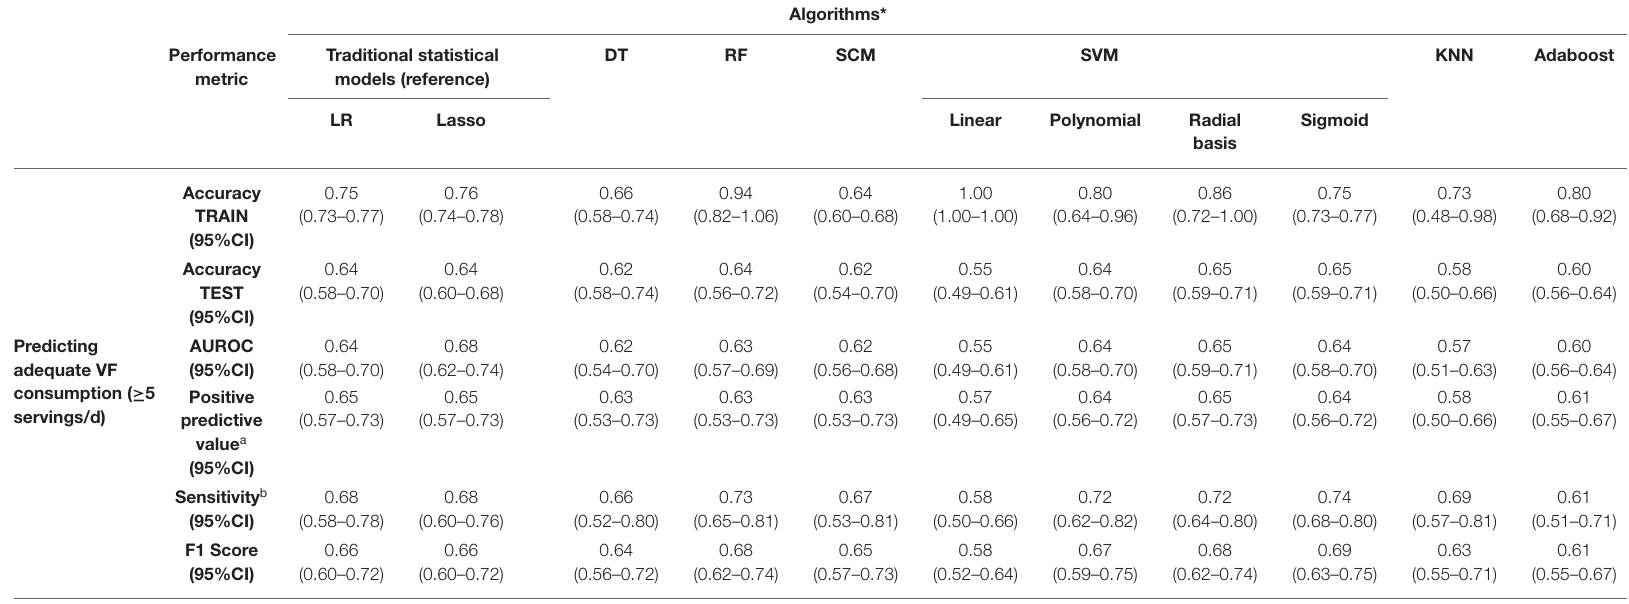
TABLE 4 | Performance metrics of two traditional statistical models and nine machine learning algorithms to predict adequate vegetable and fruit (VF) consumption based on dietary intake data obtained from web-based 24-hr recalls (R24W) among1147 French-speaking adults from Québec,